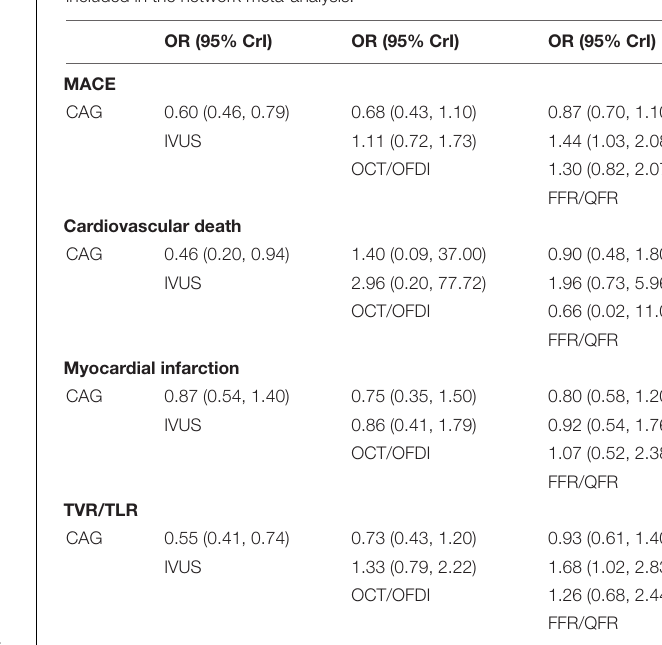
TABLE 2 | Comparisons of primary outcomes among guidance modalities included in the network